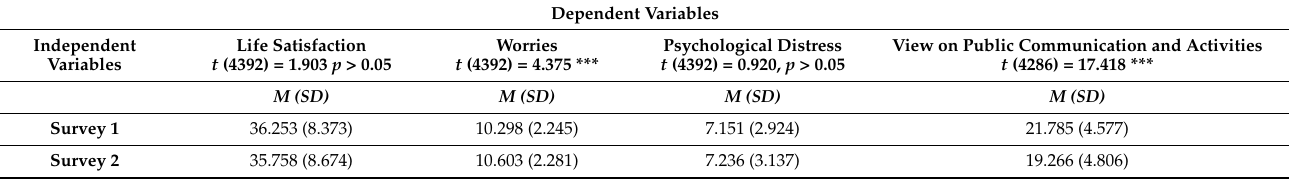
Dependent Variables